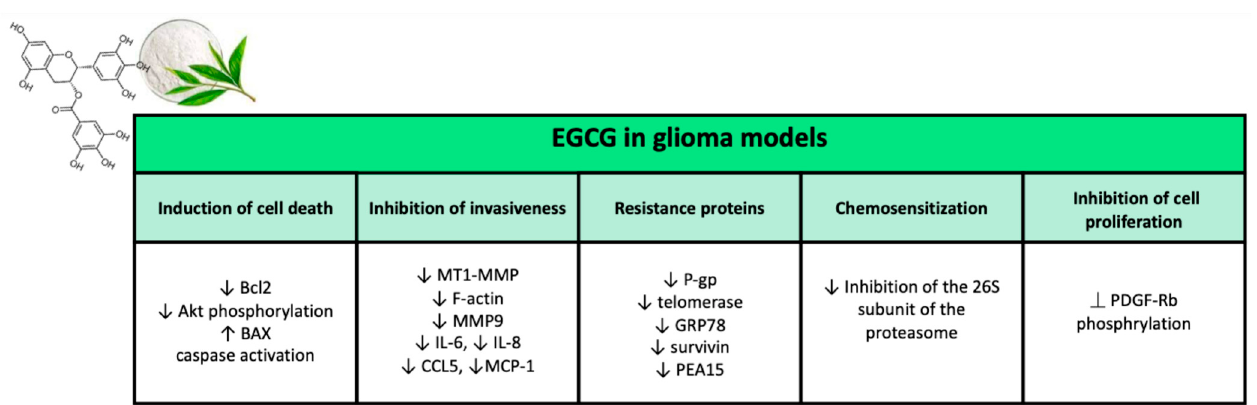
Figure 6. Major effects of epigallocatechin gallate on glioma models in preclinical studies. Inhibition of Cell Proliferation